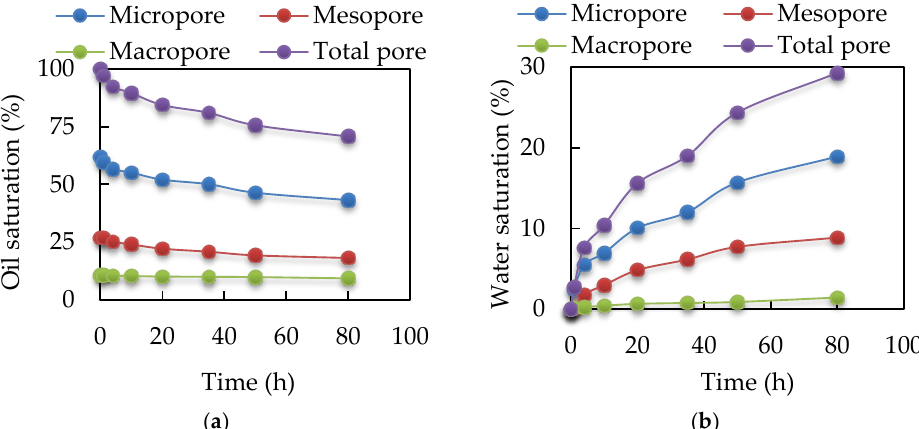
Figure 6. Oil and water saturation in various pore types over an 80-h experimental period: ( a ) oil saturation; ( b ) water saturation.